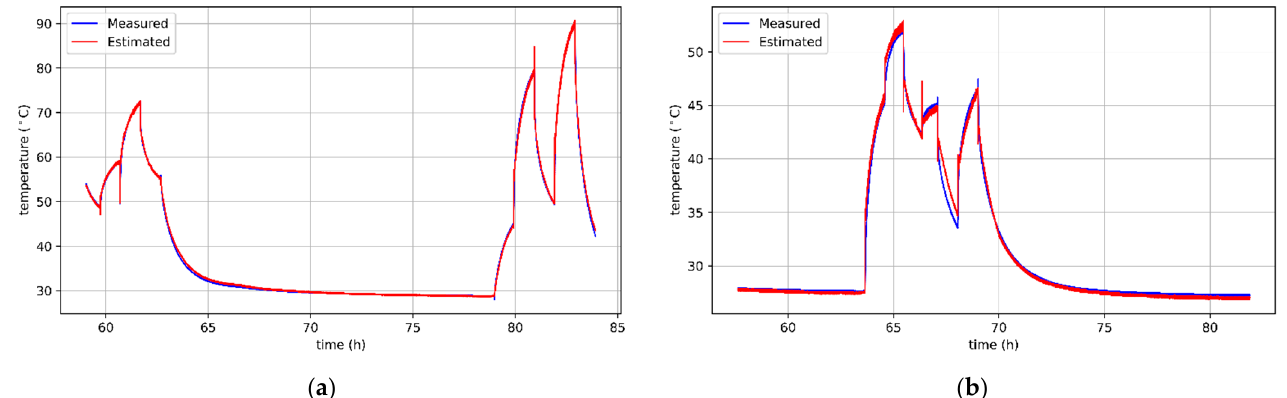
Figure 10. Results of temperature estimation supported with casing sensor data for the motor: ( a ) without cooling, obtained with SVM regressor; ( b ) with a cooling fan, obtained with SGD regressor.